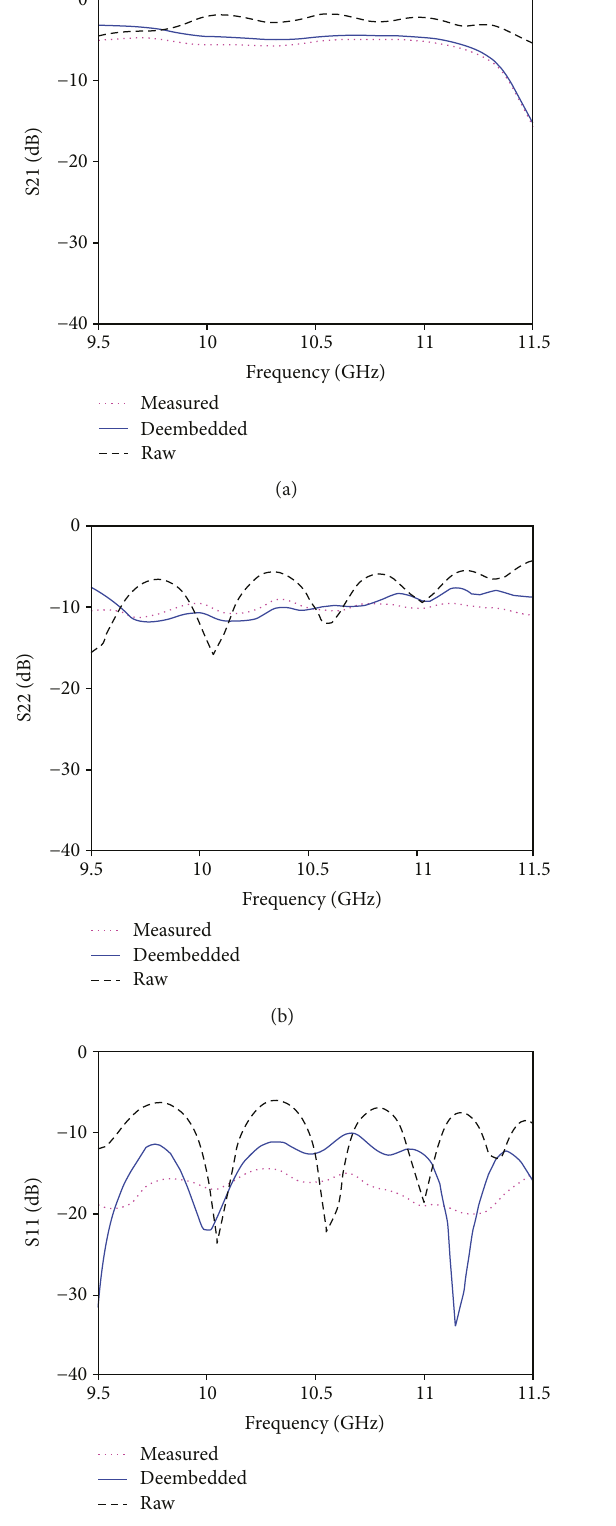
Table 2: Performance of the fabricated deembedded waveguides.